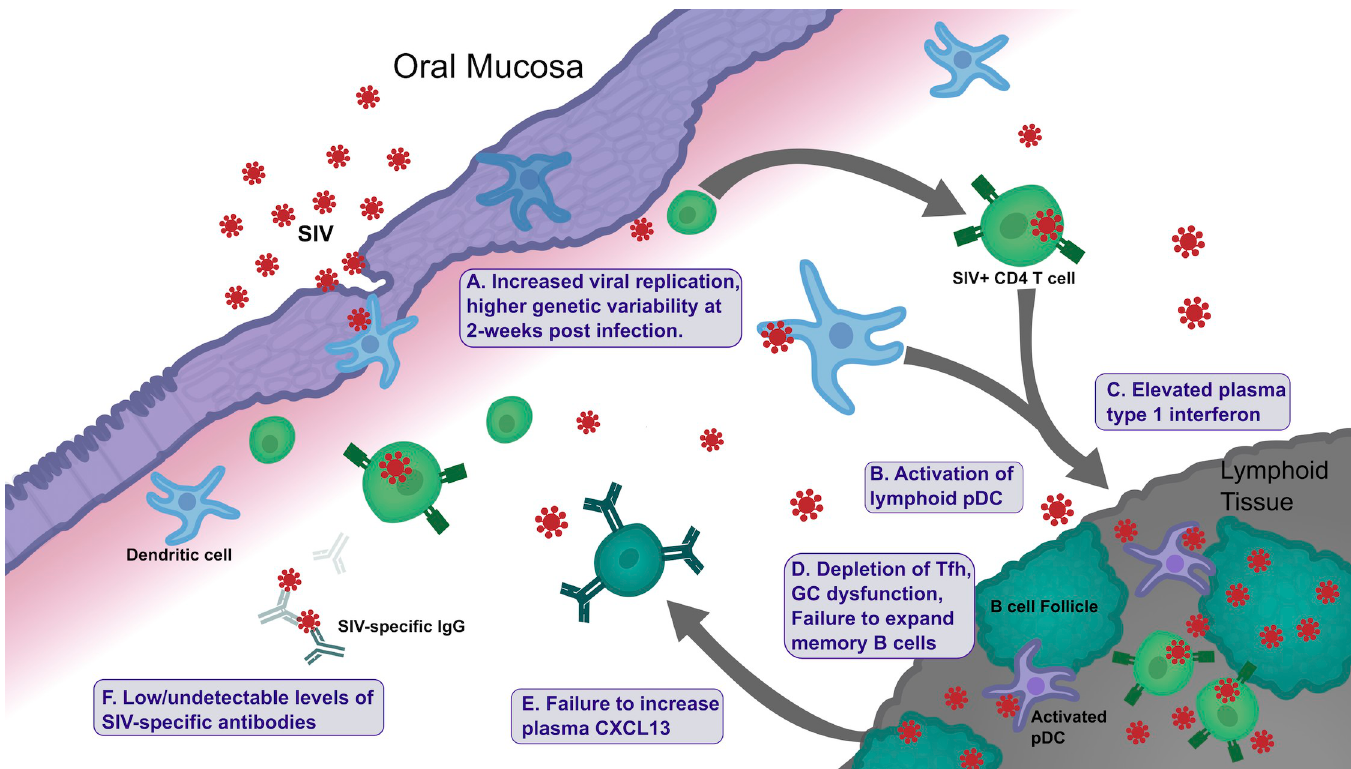
Fig 10. Model summarizing factors influencing rapid SIV progression in infants Illustration of events following infection in infant macaques exhibiting rapid disease progression. GC = germinal center; Tfh = T follicular helper cell; pDC = plasmacytoid dendritic cell.